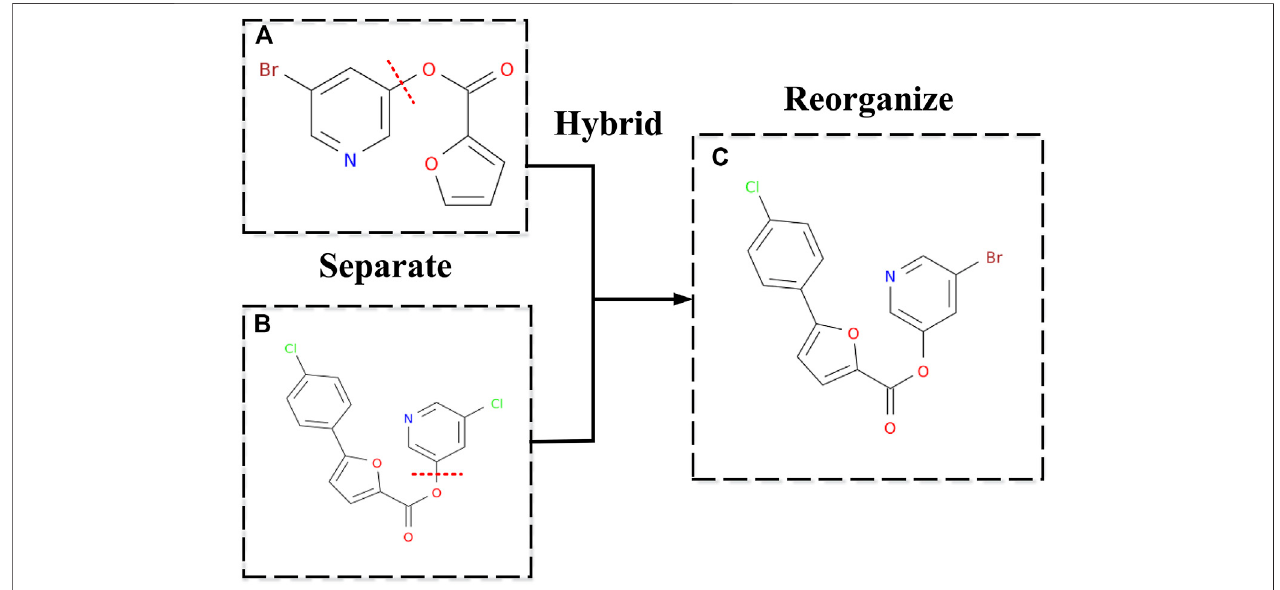
FIGURE 4 | New inhibitor ’ s molecular structure by hybridizing. (A,B) Two inhibitors were employed as examples to show how a new drug can be generated. Separatingmeansrandomlydisconnectingacutedgeinthetwoinhibitormolecules ’ graphs,whichwilldividethetwoinhibitormoleculesintofourparts. (C) Reorganizing means randomly choosing two of the four parts, which do not belong to the same inhibitor molecule, to combine the two parts and make it a new molecule by adding an edge.